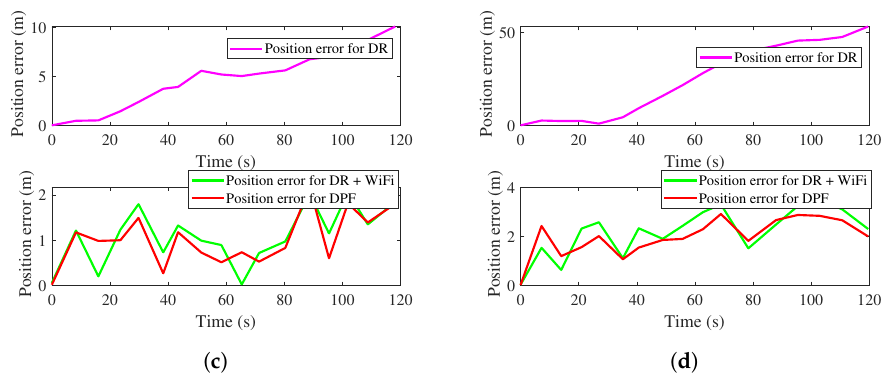
Figure 8. Position errors with different modes. ( a ) Position errors with calling mode. ( b ) Position errors with dangling mode. ( c ) Position errors with handheld mode. ( d ) Position errors with pocketed mode.